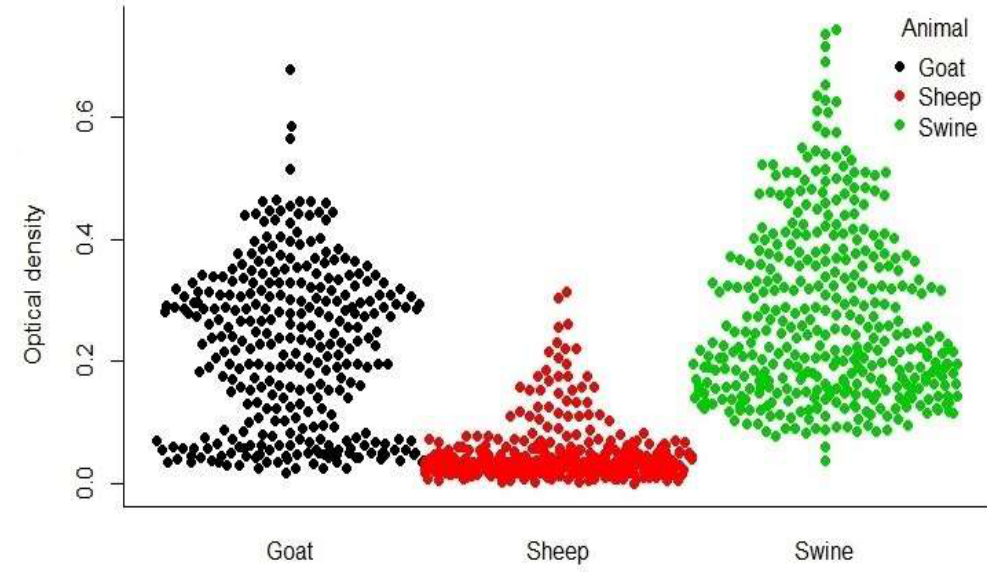
Figure 8. Distribution of optical density values of livestock sera.